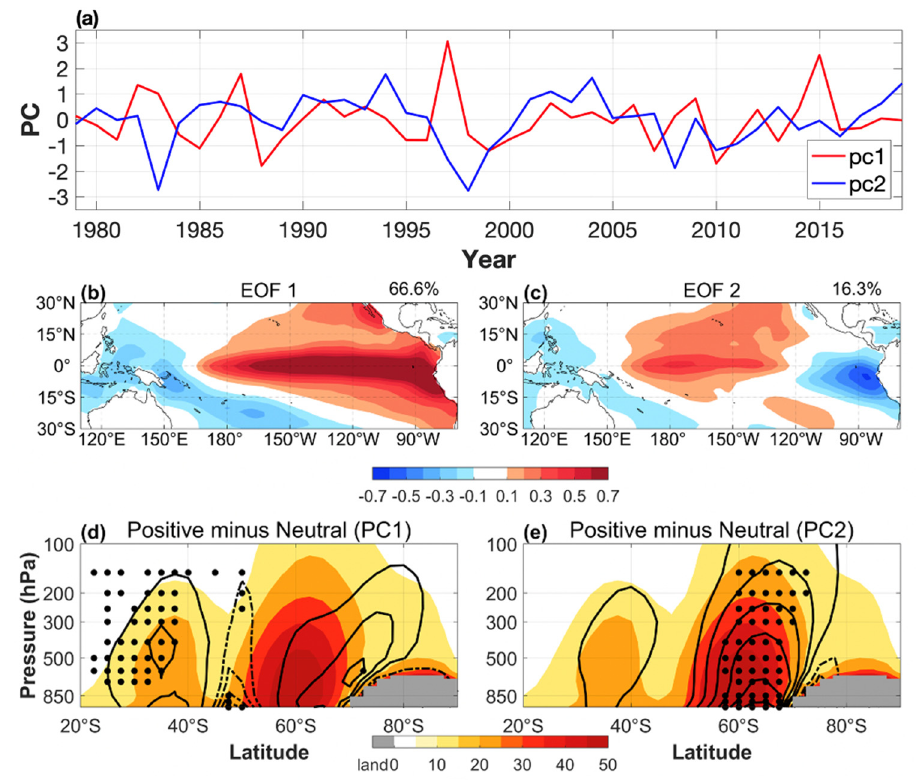
Figure 5. ( a ) Time series of normalized PC1 (red line) and PC2 (blue line). Regressions (shading; see scale bar at the bottom; unit: K) of JAS-mean SST anomalies on normalized ( b ) PC1 and ( c ) PC2. The fractional variance is shown on the top-right side. ( d , e ) Meridional sections of JAS-mean geopotential height amplitudes of zonal wavenumber 1 (Z1). Z1 are weighted by pressure/1000. The color shadings in ( d , e ) denote the climatological-mean Z1 (see scale bar at the bottom; unit: m). Contours (interval: 3m) denote the Z1 differences between the positive and neutral years defined by PC1 and PC2, respectively. The solid (dashed) contours denote the positive (negative) values. The dots denote that the Z1 differences are statistically significant at the 95% level based on a two-sided t test.